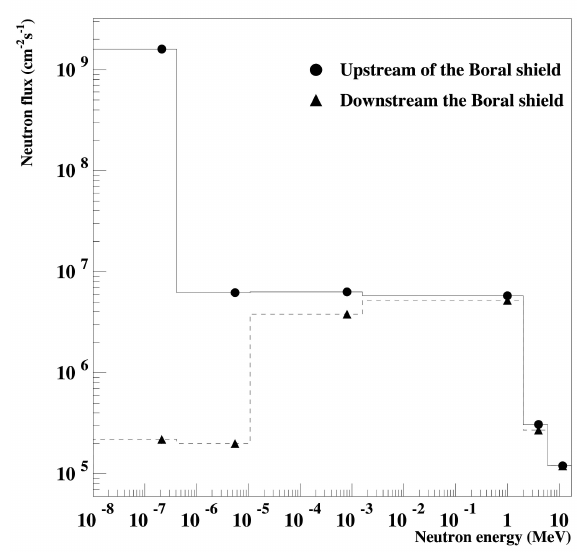
Figure 1. Simulated neutron spectrum upstream and downstream of the Boral shield; the Boral window insertion allows operating with a reduced thermal